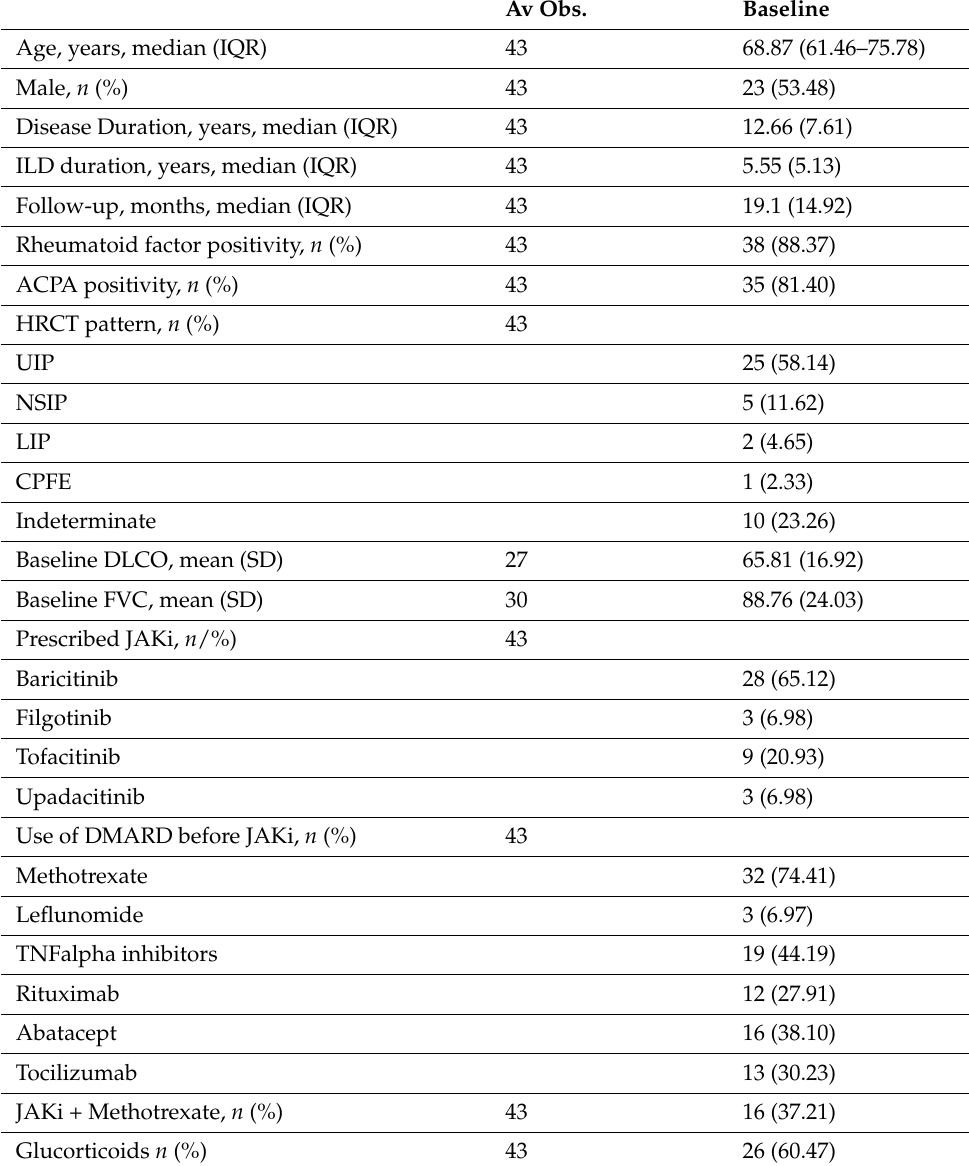
Table 1. Patient characteristics at treatment baseline.